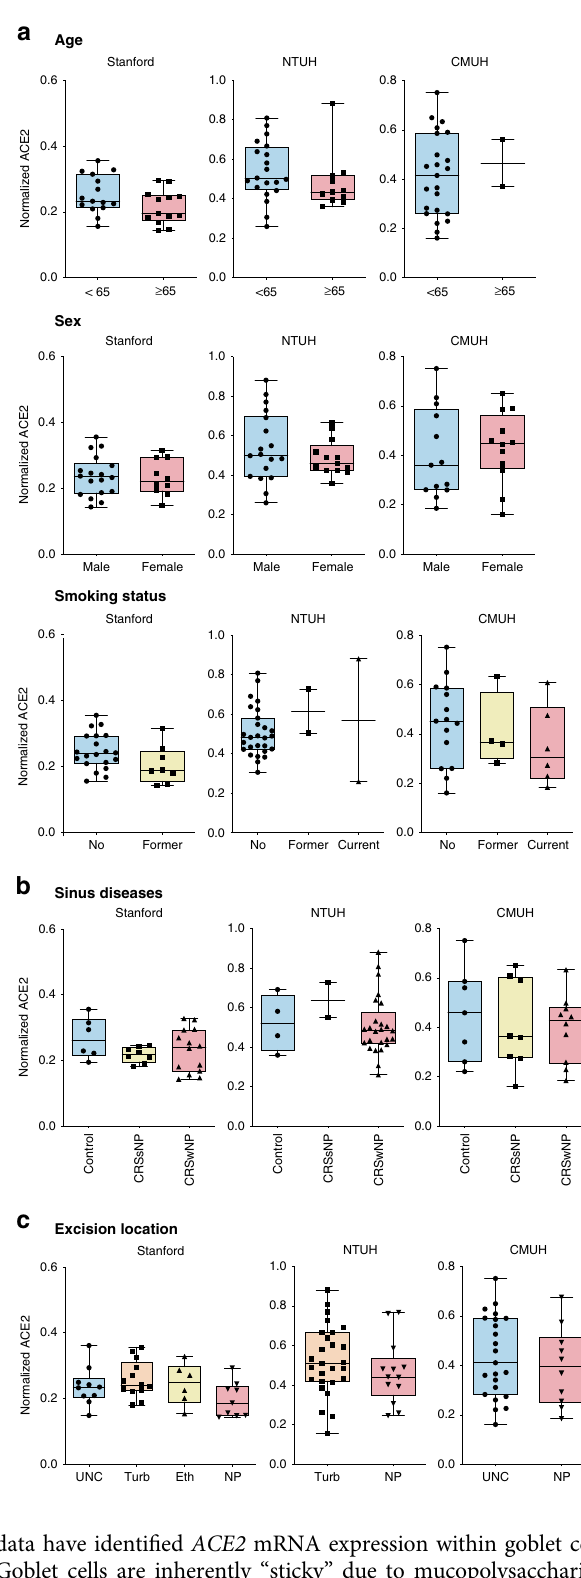
data have identi fi ed ACE2 mRNA expression within goblet cells. Goblet cells are inherently “ sticky ” due to mucopolysaccharides